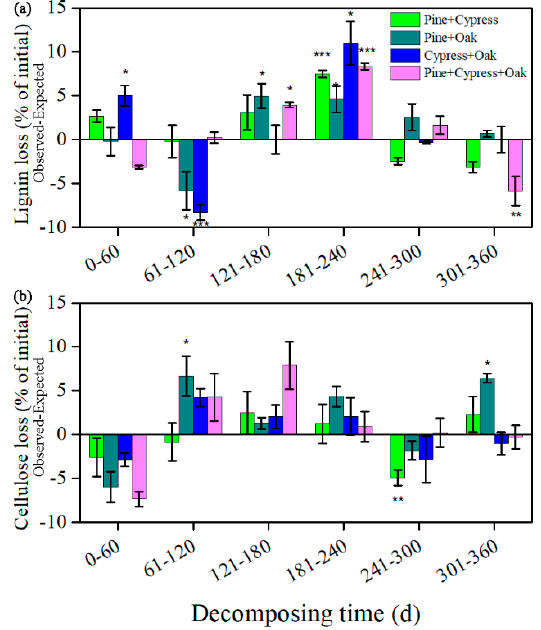
Figure 5. Mixing effects of treatments on lignin ( a ) and cellulose ( b ) losses during the different decomposition phases. Values are the mean ± SE ( n = 3). Treatments: Pine + Cypress, Pinus massoniana + Cupressus funebris ; Pine + Oak, Pinus massoniana + Quercus variabilis ; and so on. A positive value indicates an observed value > the expected value, and vice versa. Statistical significance level: ***, p < 0.001; **, p < 0.01; *, p < 0.05. Inset values indicate the proportion of the corresponding significant interactions (synergistic and antagonistic interactions lie above and below the zero line, respectively) for a total of 24 cases. Treatments: P. + C. , P . massoniana + C. funebris; P. + Q. , P . massoniana + Q. variabilis; and so on. Table 2. Summary of the generalized linear models for the effects of changing litter quality and environmental factors on the nonadditive loss of lignin and cellulose.